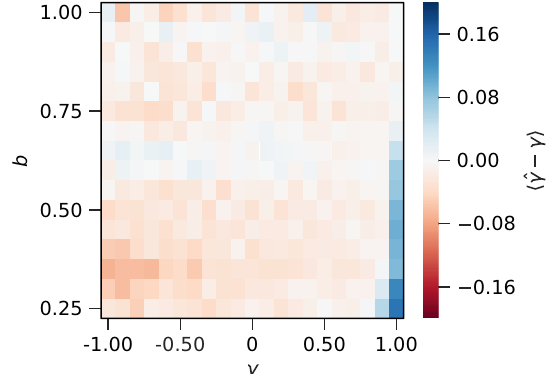
FIG. 9. Consistency of the estimator of γ in small networks. We show the average difference between the true value and estimated value of γ , for networks of T ¼ 1000 edges generated with parameters γ ∈ ½ − 1 ; 1 (cid:2) and b ∈ ½ 0 . 25 ; 1 . 00 (cid:2) . This difference is averaged over 20 different network realizations at each point of the parameter space. We use n ¼ 1000 samples each time we evaluate the average KS statistic.